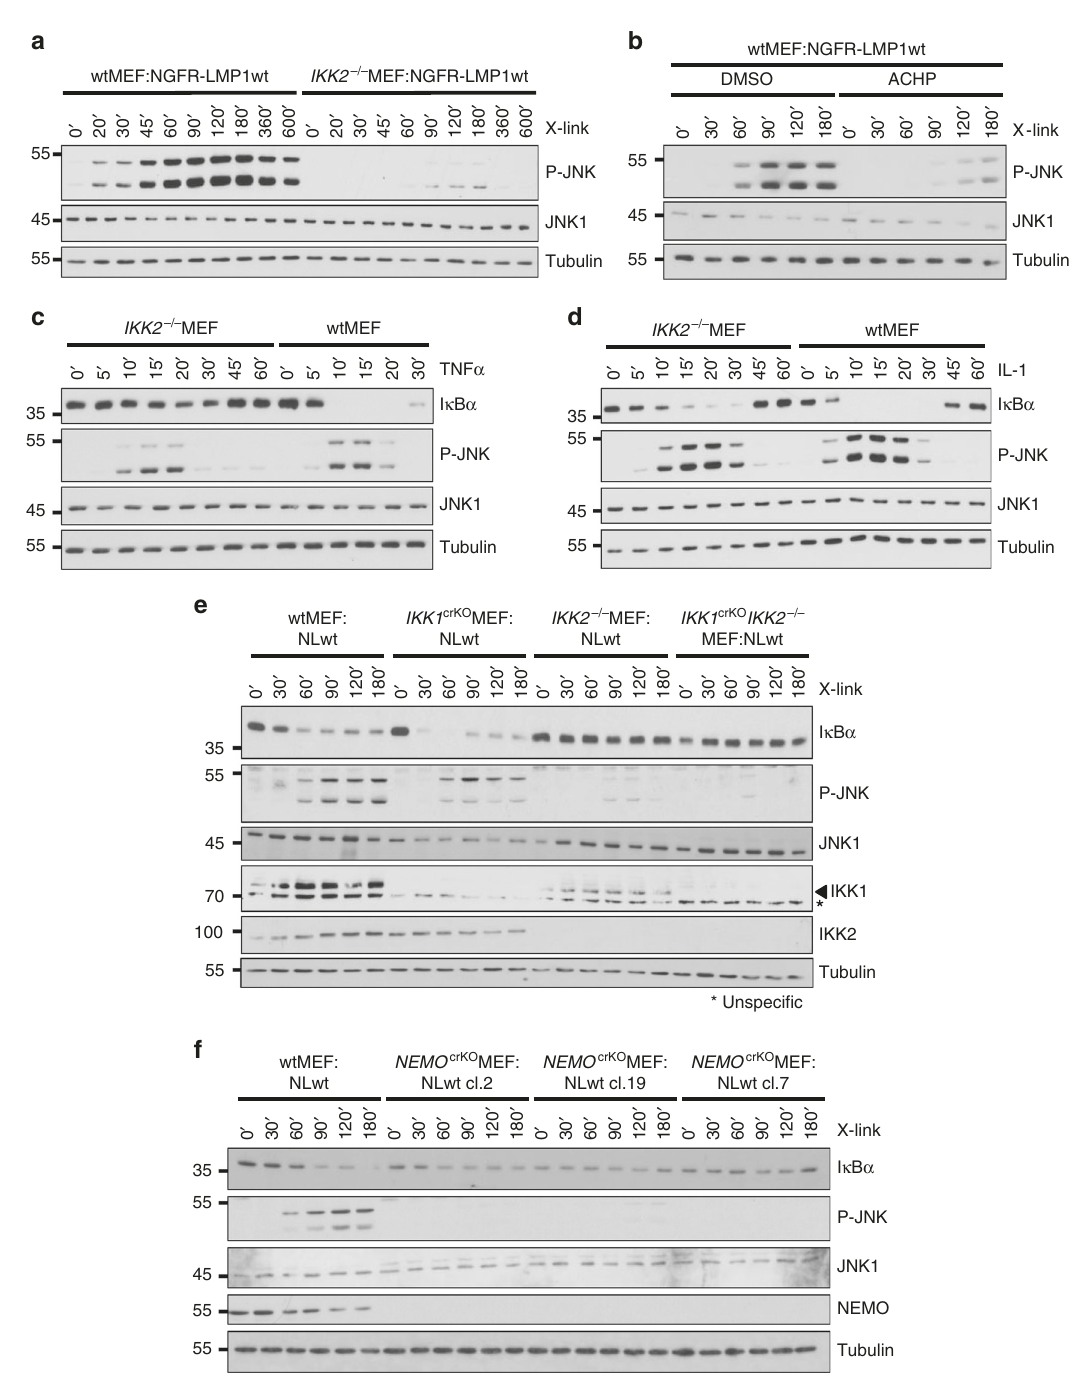
Fig. 2 Essential functions of IKK2 and NEMO in JNK activation by LMP1. a LMP1 fails to induce JNK after the knockout of IKK2 in MEFs. LMP1 activity was induced by antibody crosslinking and JNK activation was monitored by immunoblotting. b Pharmacological inhibition of IKK activity interferes with JNK activation by LMP1. NGFR-LMP1 was induced in the presence of solvent (DMSO) or 5 μ M of the IKK inhibitor VIII (ACHP). c , d IKK2 has a unique role in LMP1 signaling as compared to the TNF α and IL-1 pathways. Wildtype and IKK2 − / − MEFs were stimulated with 20 ng/ml TNF α ( c ) or 10 ng/ml IL-1 ( d ) for the indicated times. e IKK1 is dispensable for JNK activation by LMP1. IKK1 was targeted by CRISPR/Cas9 in wildtype MEF:NGFR-LMP1wt and IKK2 − / − MEF: NGFR-LMP1wt cells. LMP1 activity was induced in non-targeted, IKK1 crKO MEF:NGFR-LMP1wt (clone 69) and IKK1 crKO IKK2 − / − MEF:NGFR-LMP1wt (clone 8) cells. Activation of JNK and canonical NF- κ B was monitored. f The knockout of NEMO causes a defect in JNK activation by LMP1. NEMO was inactivated in wtMEF:NGFR-LMP1wt cells by CRISPR/Cas9 technology. NGFR-LMP1 activity was induced in non-targeted cells and the NEMO crKO clones 2, 7, and 19. JNK and canonical NF- κ B were analysed. CRISPR/Cas9 knockouts were veri fi ed by immunoblotting (this Figure) and sequencing (see Supplementary Table